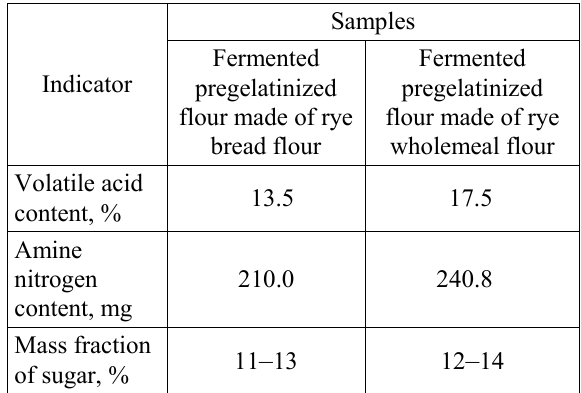
Table 2. Effect of different types of flour on